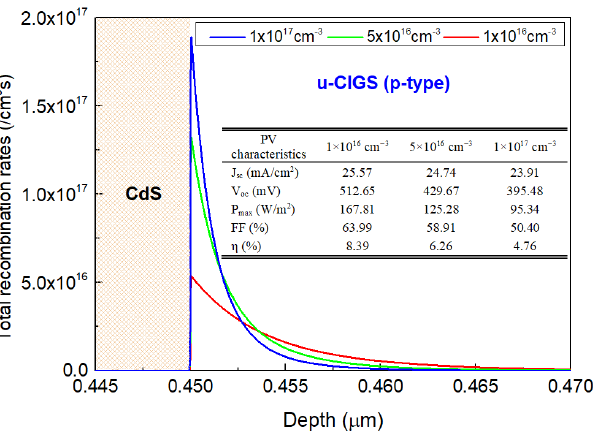
Figure 7. Recombination rates in ultrathin CIGS with different donor trap densities (N t ) at equilibrium—0 V Bias.